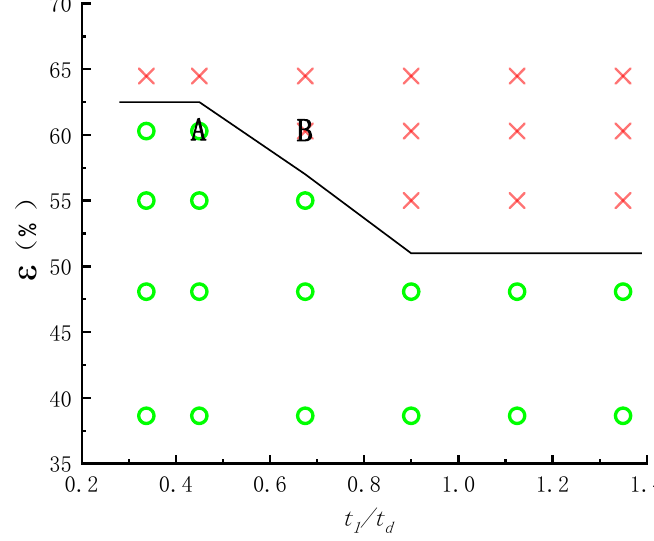
Figure 10. Forming limit diagram of roll-forming for cups. Table 3. Simulation results of different friction